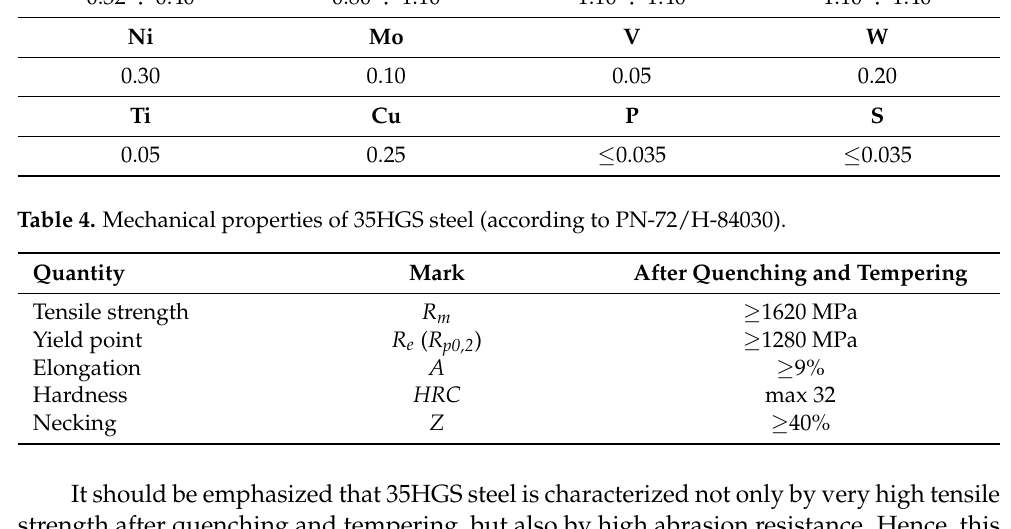
Table 3. Chemical composition of 35HGS steel (according to PN-72/H-84030). C Mn